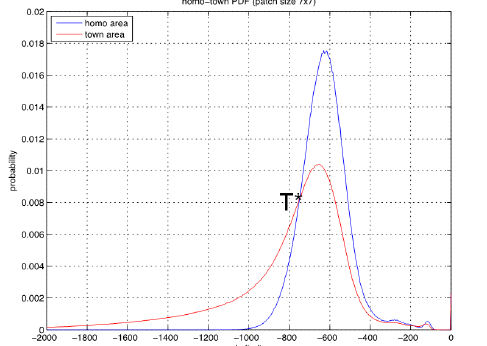
Figure 6. Probability density functions of similarity values calculated from homogeneous and heterogeneous areas